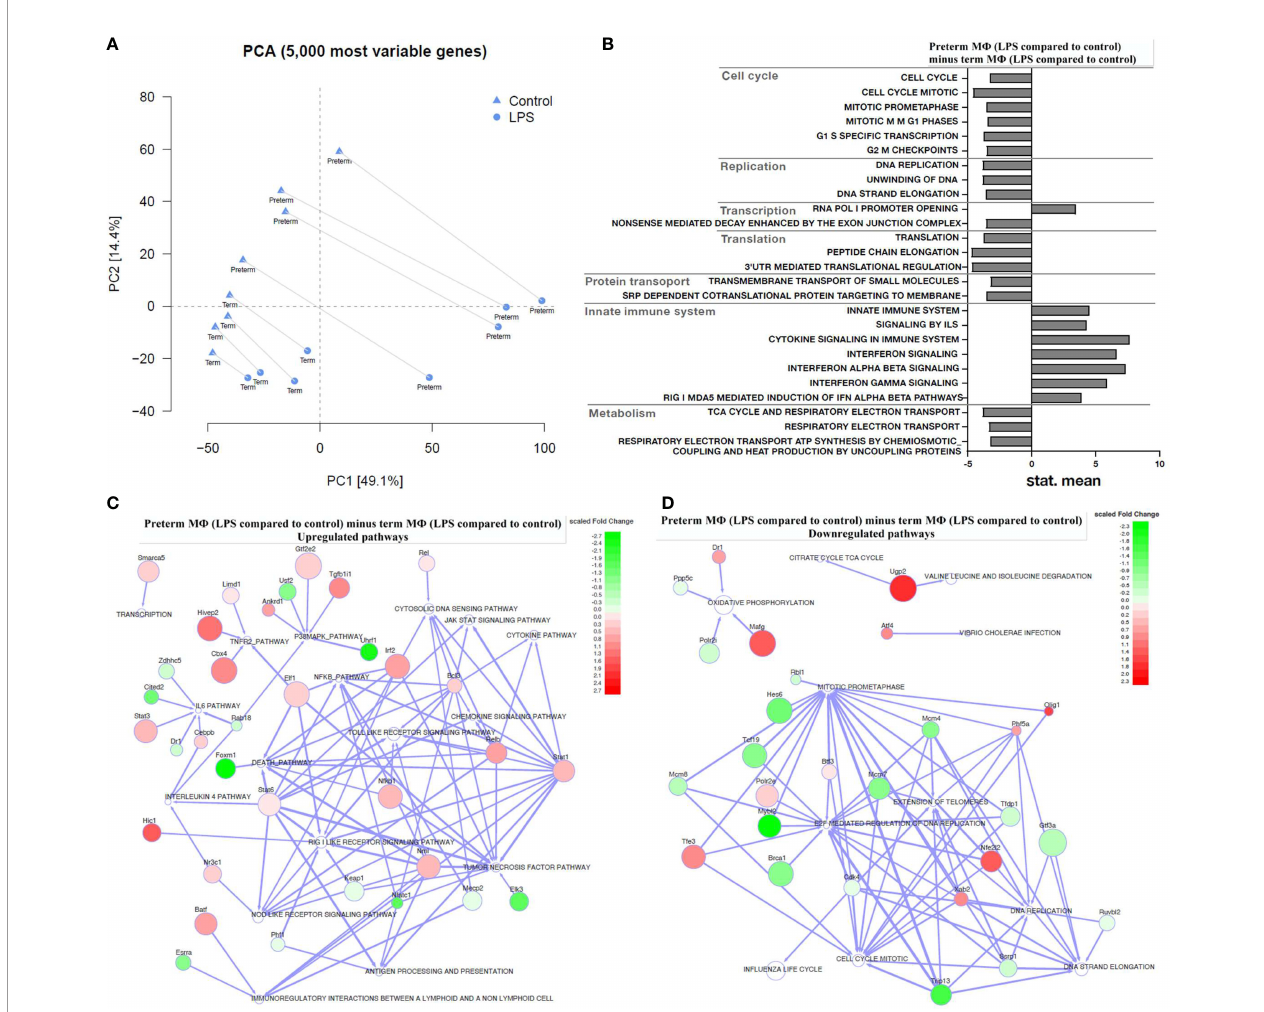
FIGURE 5 | Transcriptome analysis of LPS-stimulated preterm macrophages (M F ) compared to term M F . Preterm and term M Ф were incubated for 72 h (48 h 21% O 2 followed by 24 h 21% O 2 with or without LPS). (A) Principal component analysis (PCA) to show distribution of samples based on the 5000 most variable genes in the RNA samples of M F . The PCA plot shows clusters of samples based on their similarity, which revealed clustering of RNA samples from preterm and term M F dependent on LPS stimulation (cluster symbols: triangles=control and circles=LPS; paired samples are connected) and gestational age (preterm vs . term labeling). (B – D) The bar graph and the regulator networks combine the effect of gestational age and stimulatory condition by comparing the difference of LPS stimulation with control (21% O 2 ) from preterm M F to the same difference from term M F . (B) The pathway pro fi le is based on the REACTOME gene sets (provided by MSIGDB library) after input of differentially regulated genes (unpaired t-test, p adj < 0.05) from preterm and term M Ф . It shows the “ mean of gene set ” -values which were signi fi cantly regulated. The following categories were detected: cell cycle, replication, transcription, translation, protein transport, innate immune system, and metabolism. ( “ mean of gene set ” test statistic, p adj < 0.05). (C) Upregulated and (D) downregulated pathways (white) due to signi fi cant difference in key transcriptional regulators (green: downregulated transcription factors; red: upregulated transcription factors; TRAP analysis; GAGE cutoff p<0.1; regulator cutoff p<0.01). (A – D) : n=4 independent experiments with cells of four different donors (3 out of 4 donors are the same as Figure 2 72 h time